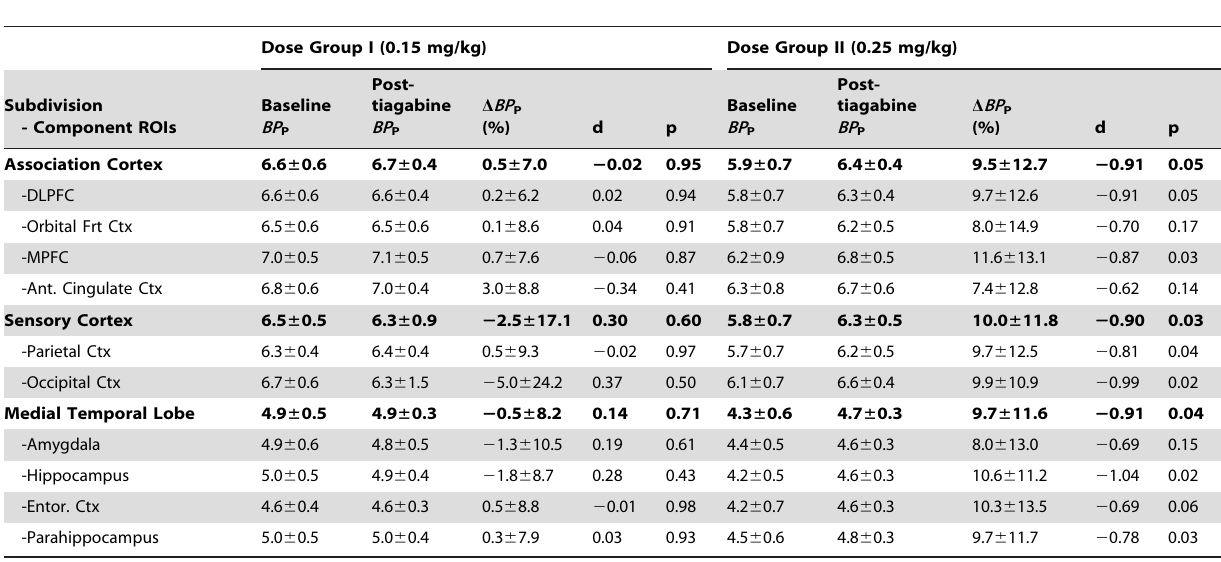
Table 4. Tiagabine-induced change in [11C]flumazenil BP P in control subjects.